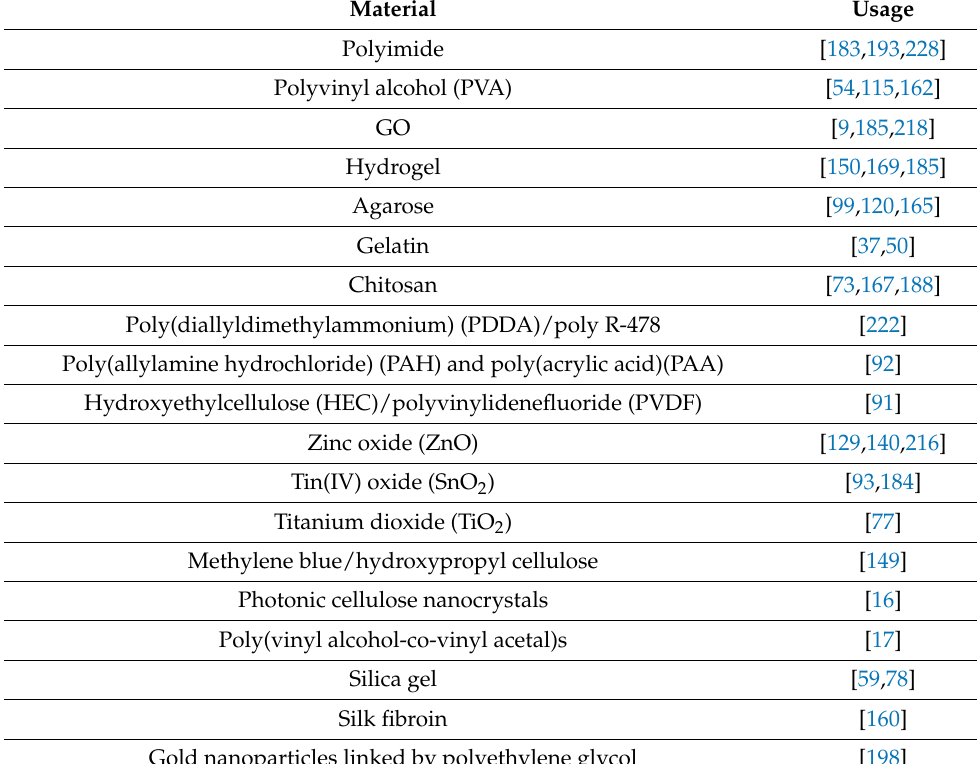
Table 4. Table of functional materials used for humidity